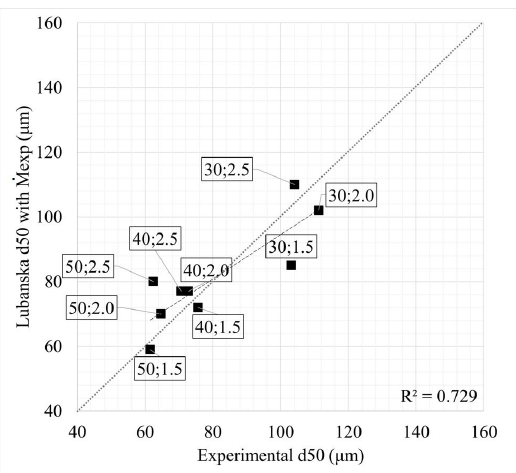
Figure 3. Experimental v.s. Lubanska d50 values with experimental metal flow. The data labels represent the gas pressure and tip diameter of each experiment.